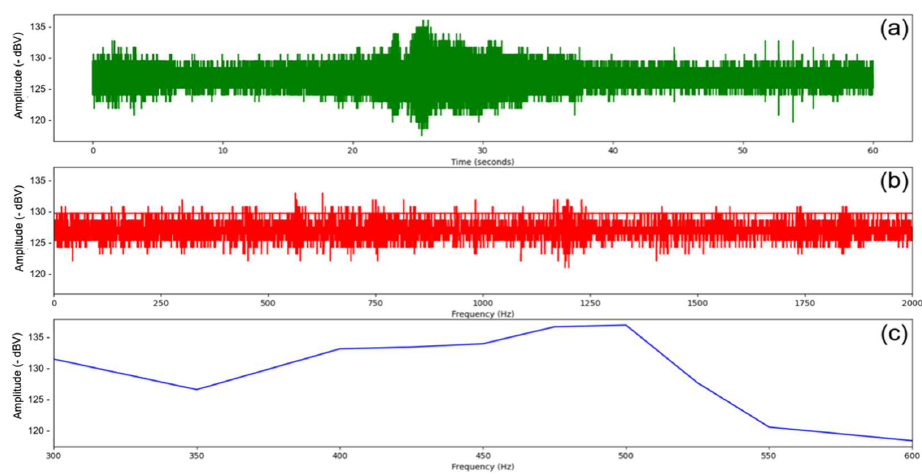
Figure 5. Representation of ( a ) signal during a minute, ( b ) frequency in the band of (0 − 2000 Hz), and ( c ) aggregated frequency response (in 10 bins).